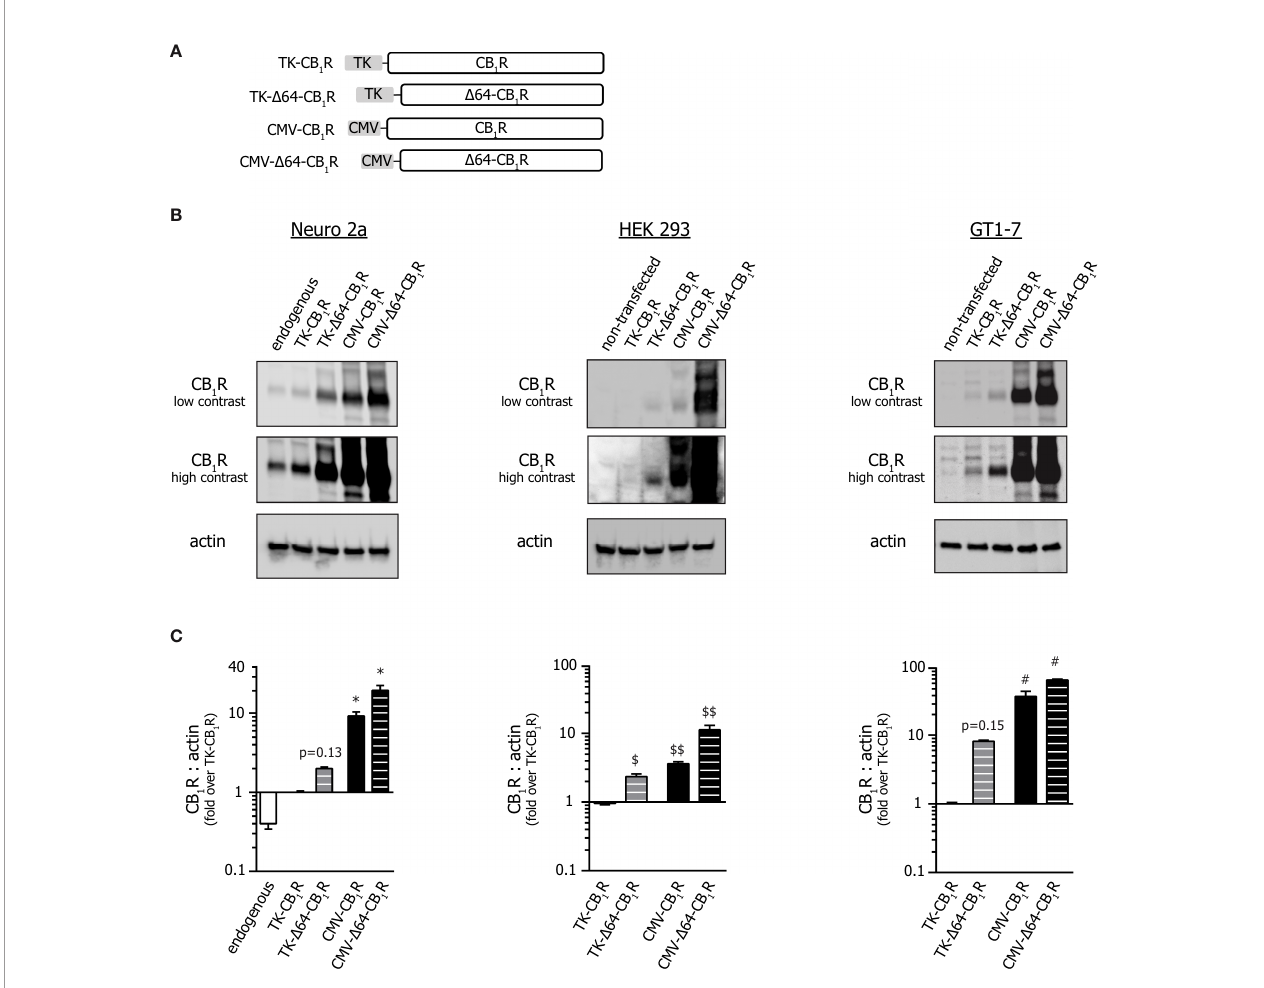
FIGURE 1 | Effect of promoter and N-terminal truncation on CB 1 R expression. (A) Schematic representation of the various CB 1 R clones used throughout the study. (For GFP-tagged versions, see Supplementary Figure 3A .) (B) Western blot analysis of the expression of various CB 1 R constructs in Neuro 2a, HEK 293 and GT1-7 cells. Cells were transfected with different CB 1 R constructs or with empty plasmid (pcDNA3.1(+); ‘ non-transfected ’ ); in order to perceive the differences in expression better, both low and high contrast representations of the same 16-bit raw images are presented. (C) Statistical analysis of immunoblots shown on Panel (B) . CB 1 R to actin expression ratios were normalized to that obtained in TK-CB 1 R expressing samples. From left to right n= 9-13-14-12-11 (Neuro 2a); 14-13-11-10 (HEK 293) and 11-9-10-10 (GT1-7); *p < 0.0003, $ p = 0.0152, $$ p < 0.0001 and # p < 0.0001 as compared to pertinent TK-CB 1 R group (Kruskal-Wallis ANOVA followed by Dunn ’ s multiple comparisons